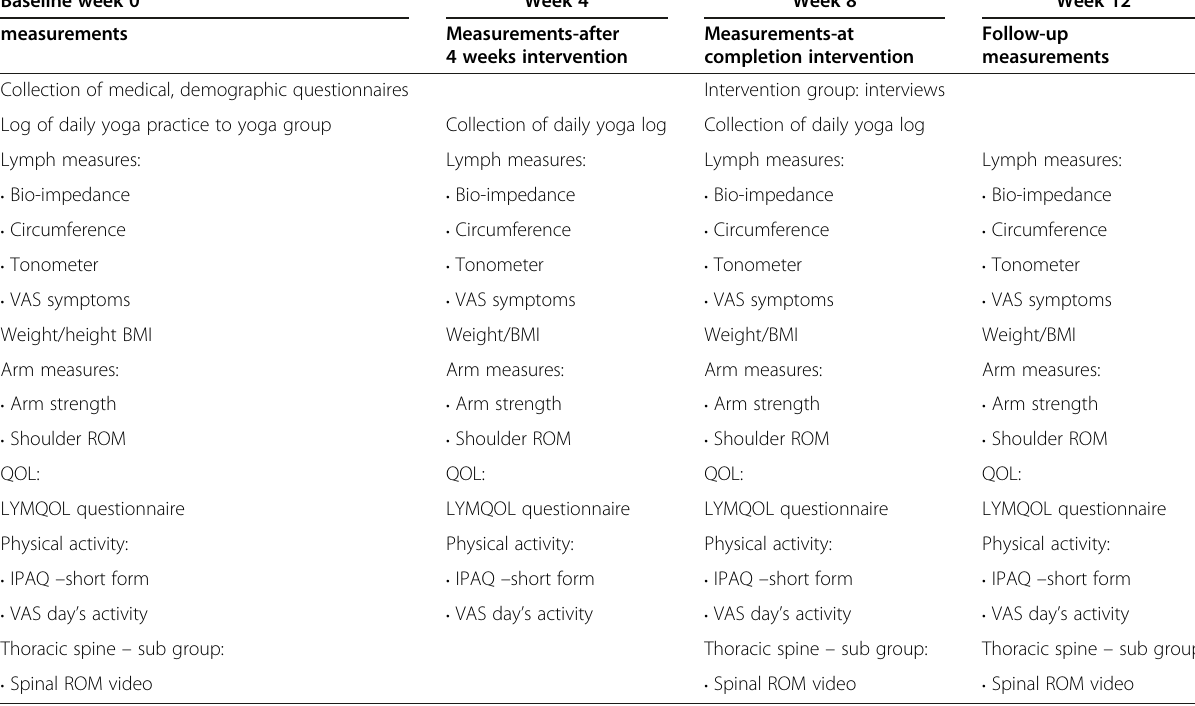
Table 1 Outcome measurements at baseline, weeks 4, 8, 12 Baseline week 0 Week 12 measurements Measurements-after